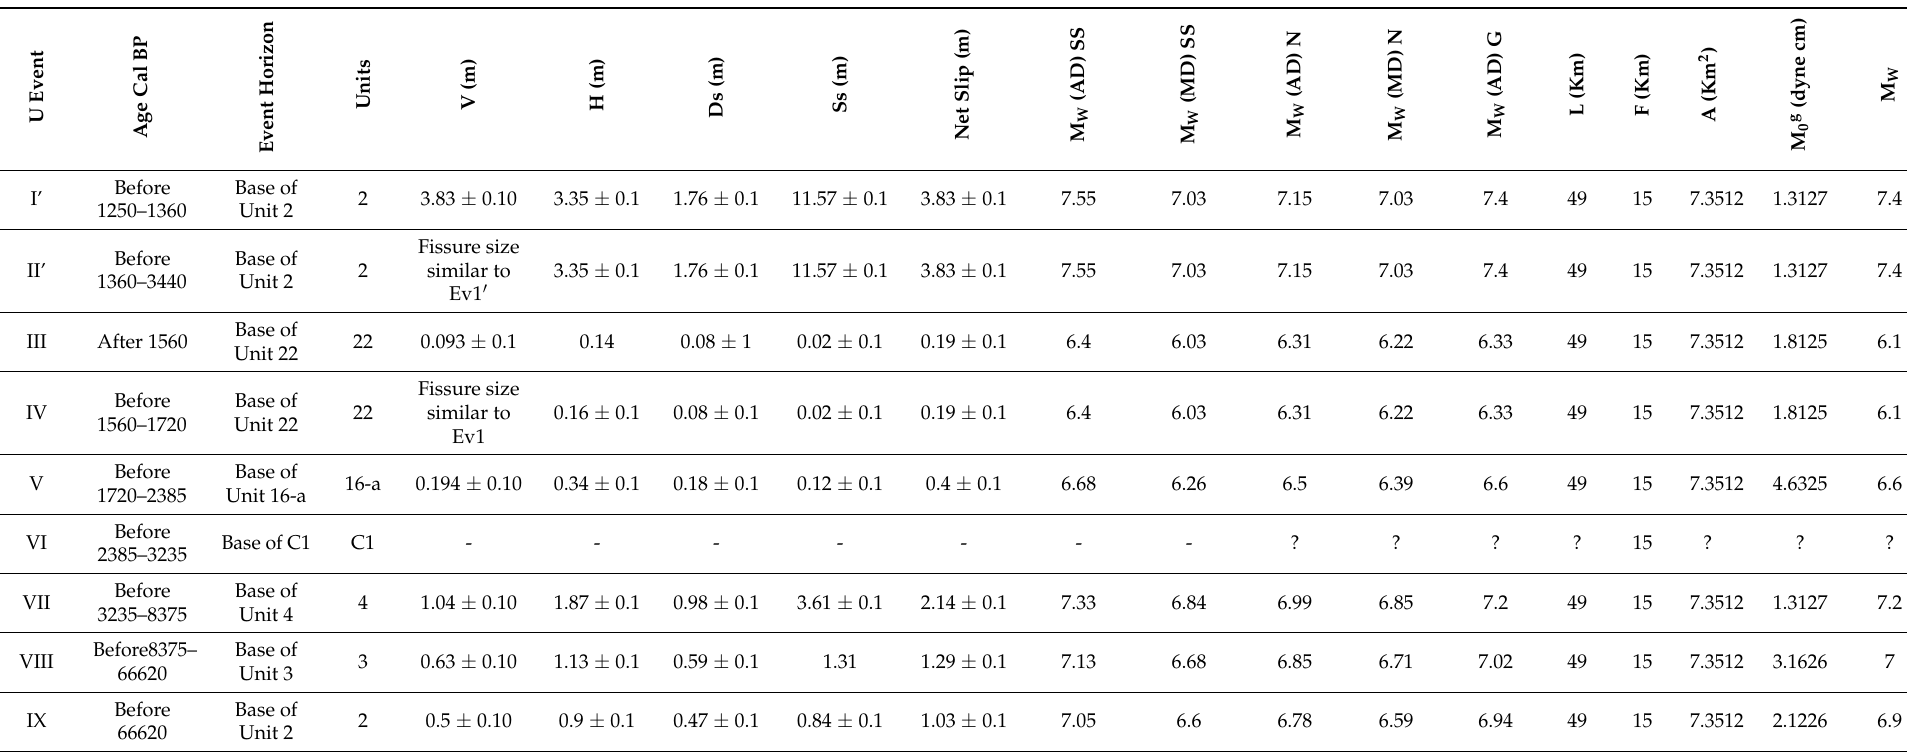
Table 3. Geometrical and seismic parameters of the Doroud Fault (obtained from TC